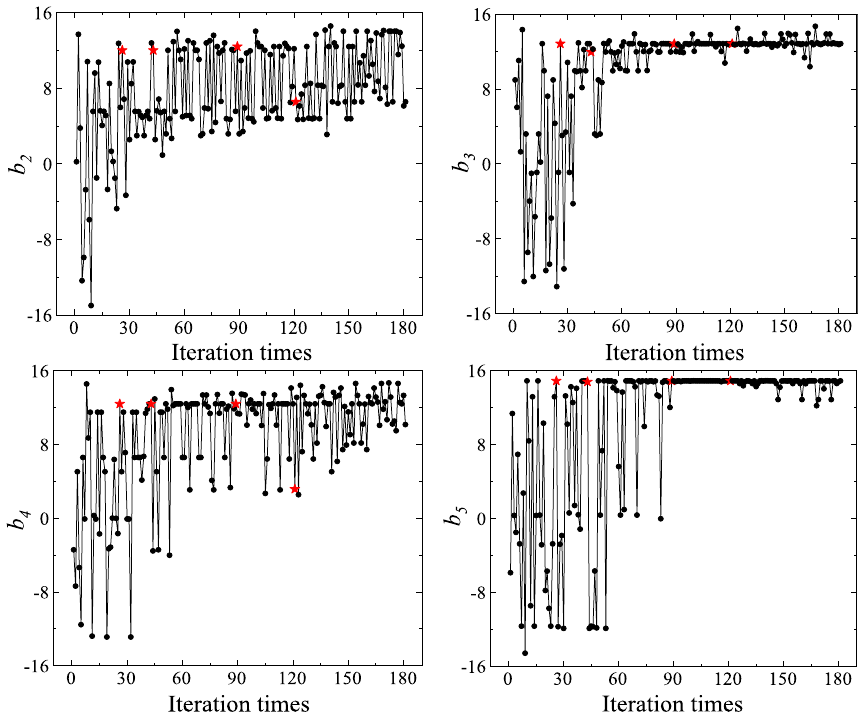
Fig. 13 The historical curves of the design variables in the optimization